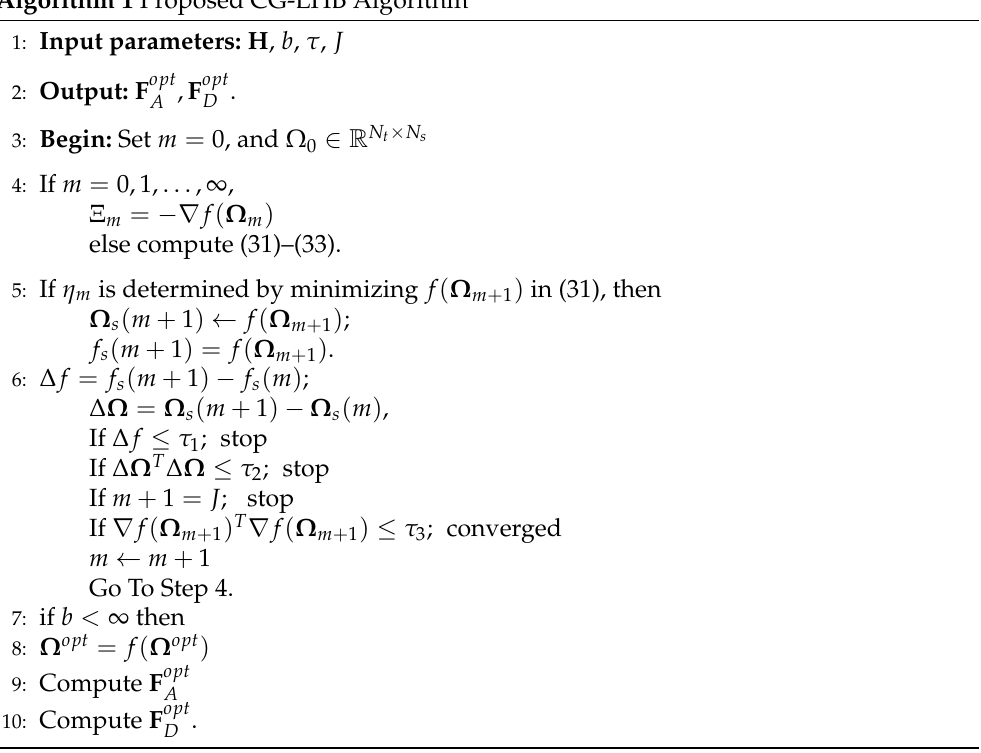
Algorithm 1 Proposed CG-LHB